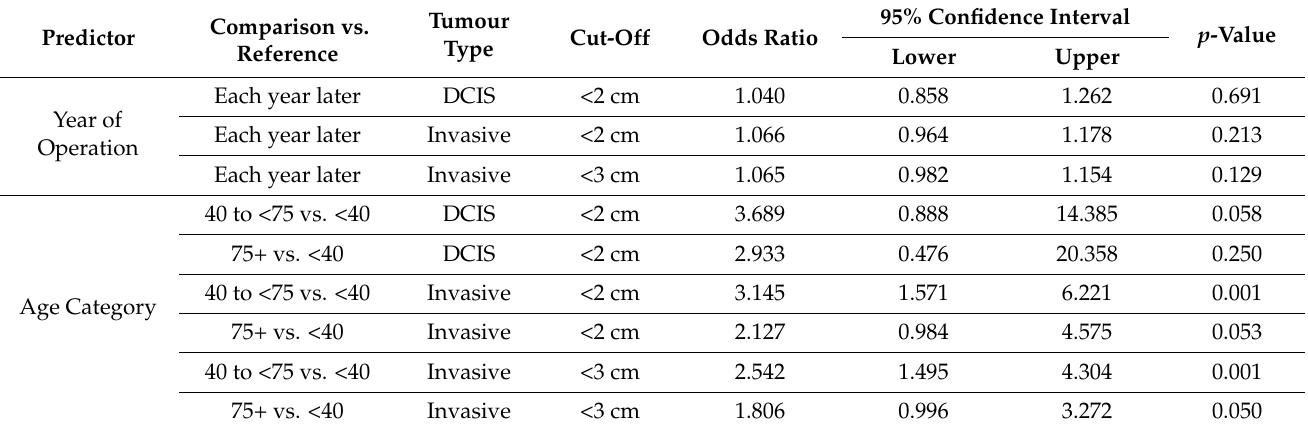
Table 3. Time and age trends for BCS rates by tumour type (invasive cancer or DCIS) and size (cm). Comparison vs. Predictor